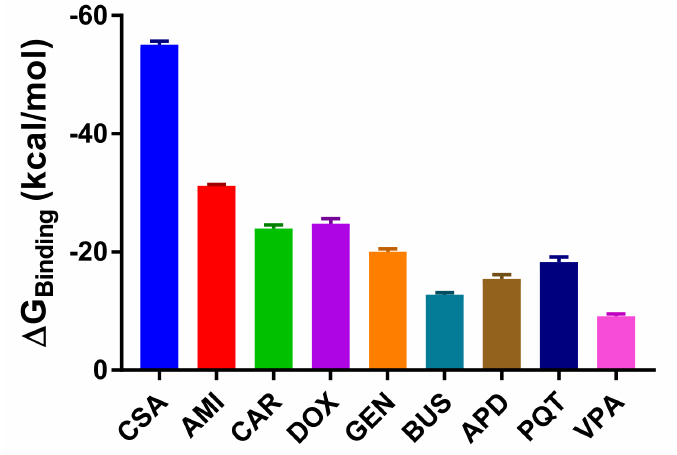
Figure 8. Bar graph of the estimated free energy of binding for the ligand–P-gp complexes studied using MM/PBSA calculations over 100 frames sampled from the entire 500ns trajectory ( n = 100, mean ± SEM). Error bars: